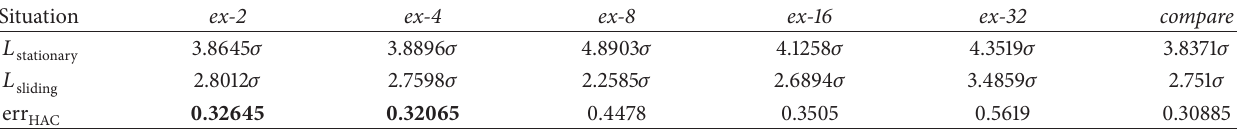
Table 13: Slip length prediction of six situations and unified relative errors with different 𝑒𝑥 𝑠𝑡𝑒𝑝𝑠 and equal 𝑁